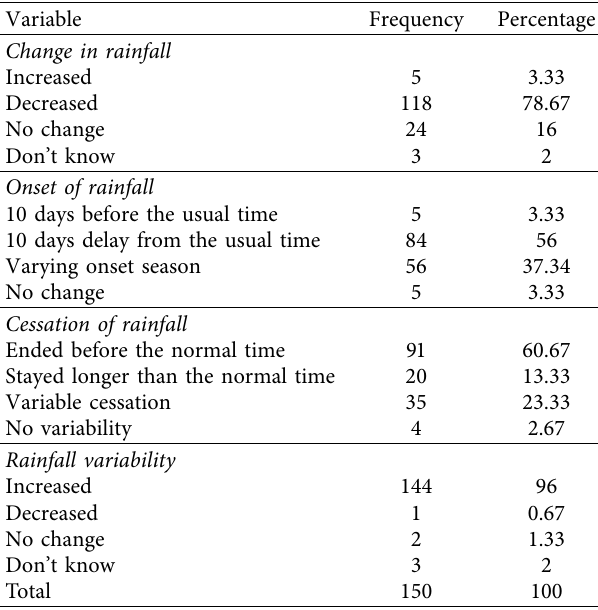
Table 2: Perceptions of the respondents on change in rainfall over the